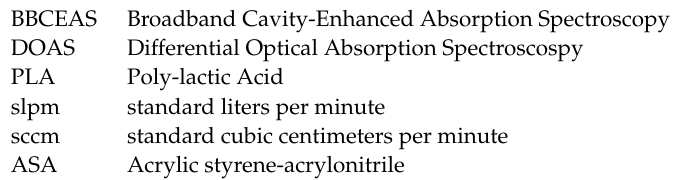
Figure S2: Ambient measurements of SO 2 ; Figure S3: Correlation of ambient data from Figure S3 for BBCEAS measured [SO 2 ] relative to the 43i; Figure S4: Response of BBCEAS vs. fluorescence detection in the presence of